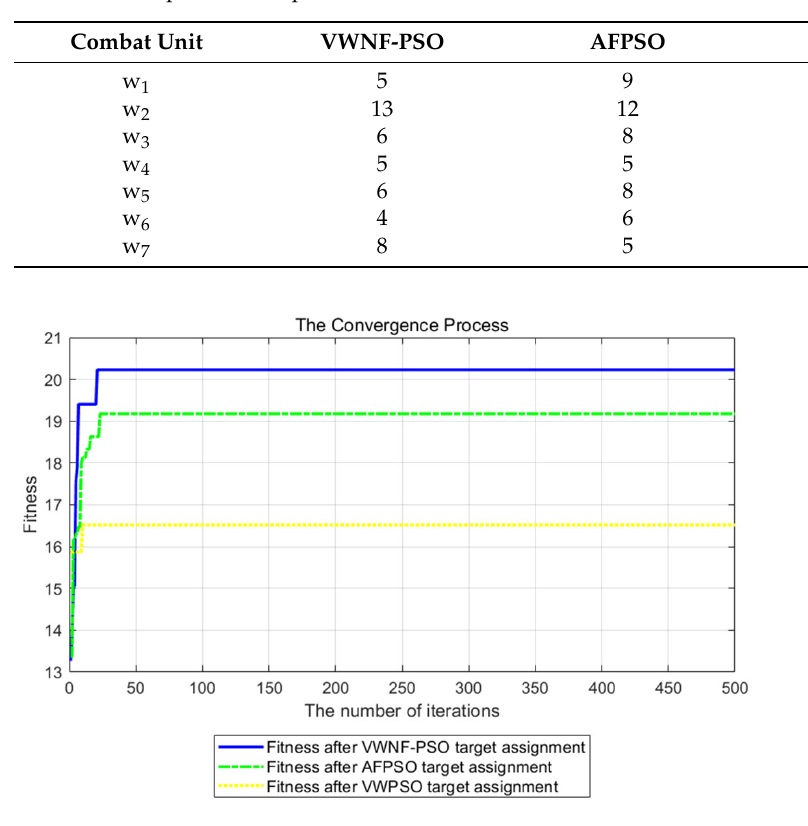
Figure 8. Algorithm fitness comparison.